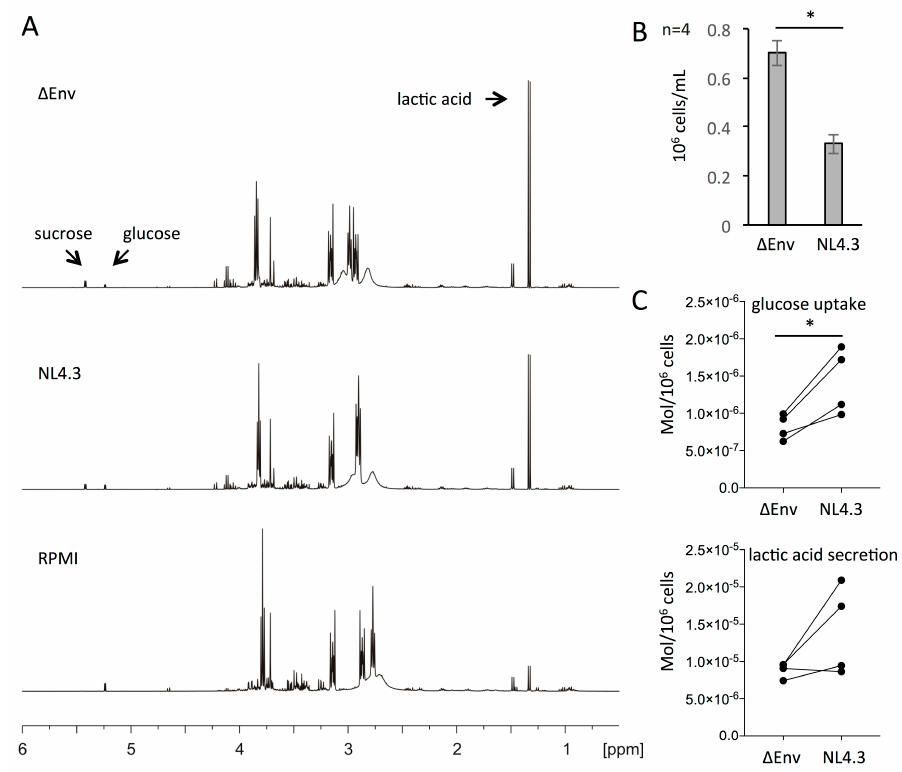
Figure 3. 1 H-NMR analysis of glucose consumption and lactic acid production of HIV-1 infected and uninfected CD4+ T cells. ( a ) Representative 1 H-NMR spectra of the supernatant of CD4+ T cell cultures infected with HIV-1 NL4.3 or a non-infectious control ( ∆ Env), as well as RPMI media without cells. Arrows indicate peaks corresponding to sucrose, glucose, and lactic acid; ( b ) The numbers of CD4+ T cells present in the cultures ( ∆ Env or wt NL4.3) used for NMR analysis after 24 h; ( c ) Cell number-corrected glucose uptake and lactic acid production after 24 h of culturing CD4+ T cells infected with HIV-1 NL4.3 or the non-infectious ∆ Env control. Significance is indicated by * p ≤